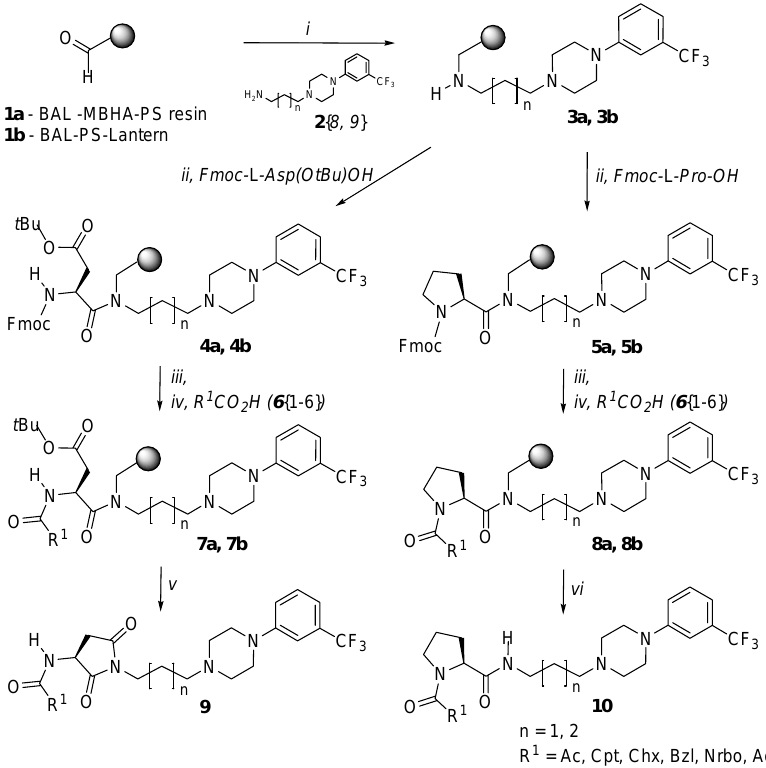
Scheme 1. Synthetic route to N -acyl-3-aminopyrrolidine-2,5-diones and N -acylprolinamides: